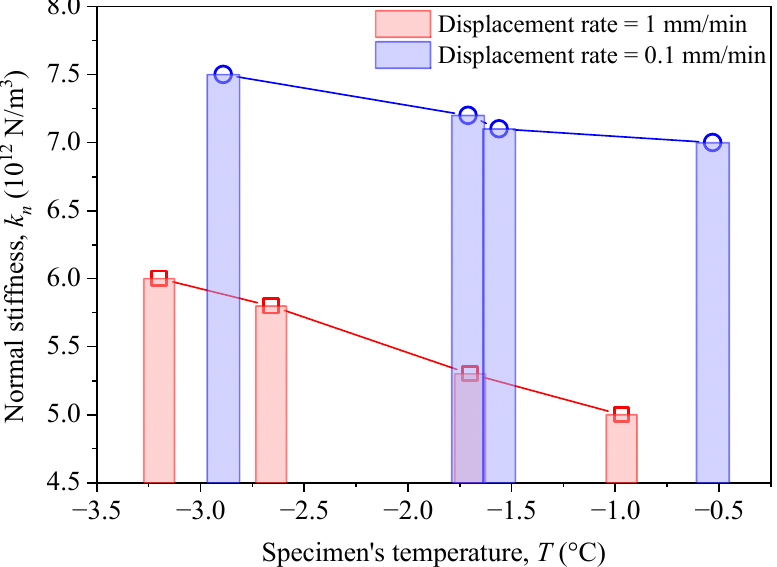
Figure 9. The relationship between the normal stiffness and the specimen’s temperature.